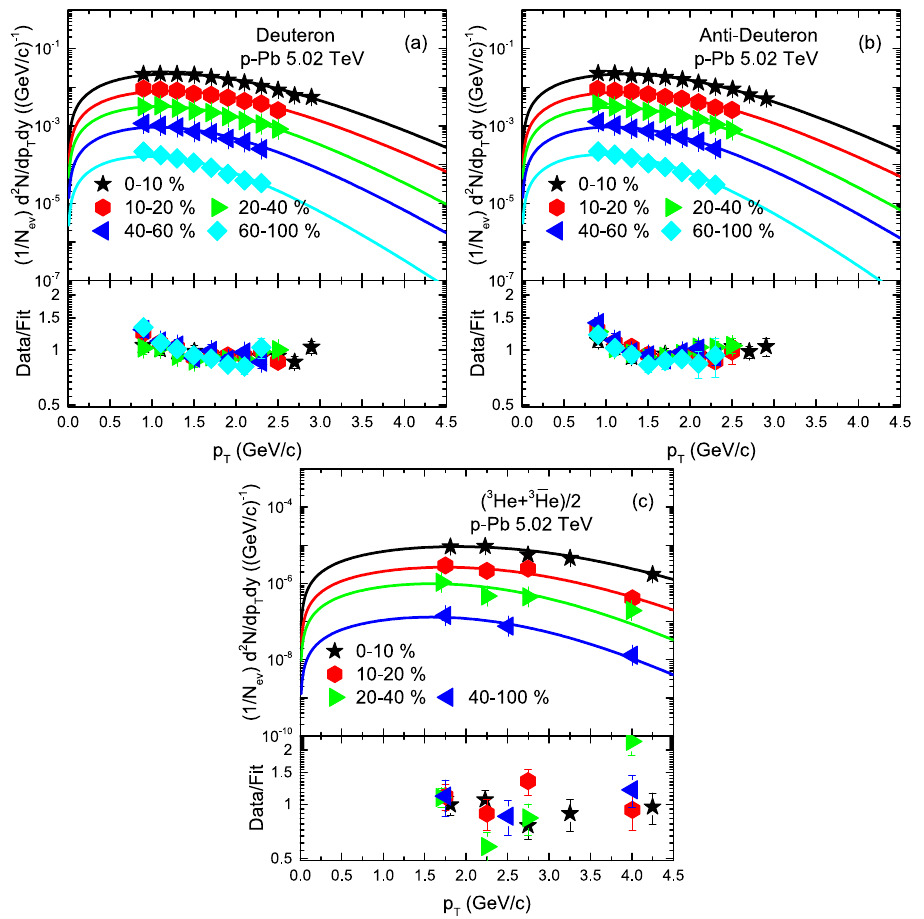
¯ 3 He ¯ d and ( c ) ( 3 He + )/2 produced in various centrality